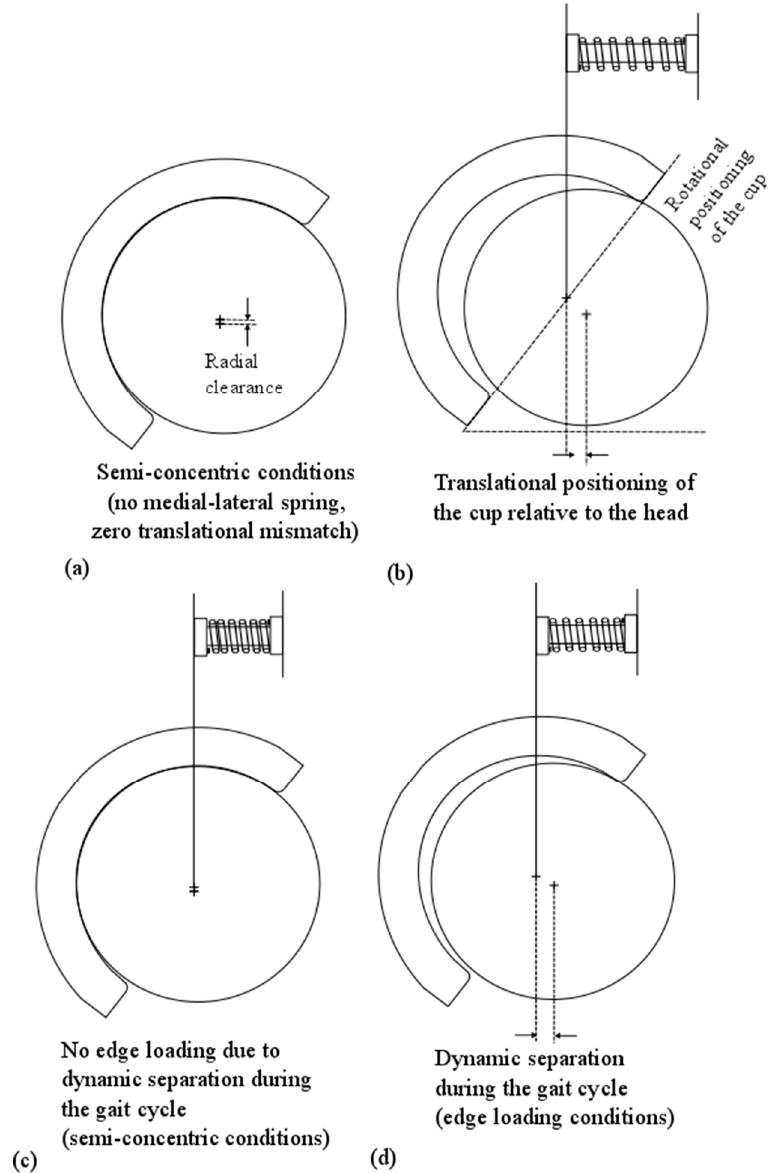
Figure 3. ( a ) Concentric conditions without a medial-lateral spring, ( b ) rotational positioning and translational surgical positioning, ( c ) semi-concentric head and cup conditions at peak load during the stance phase and ( d ) dynamic separation between the head and cup during the gait cycle.